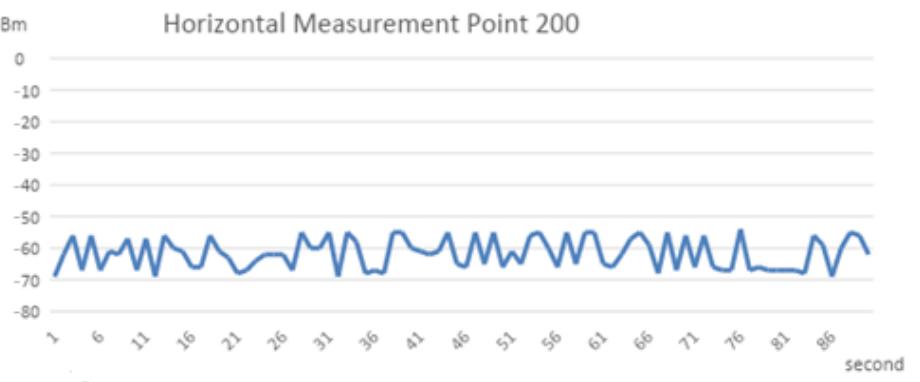
Figure 3. Line chart of the horizontal measurement signal.